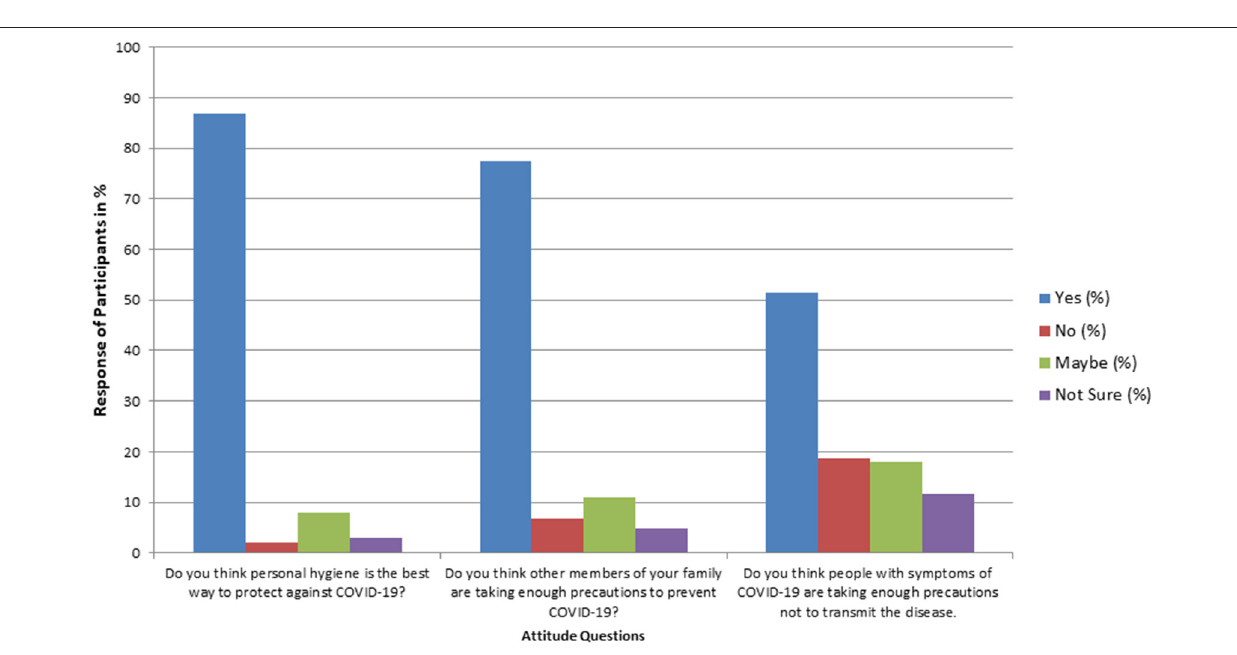
from different categories did not differ significantly other than in the provinces. Practices were good in Baluchistan participants (70%) and poor from KPK (30%) ( p < 0.001) ( Supplementary Table 2